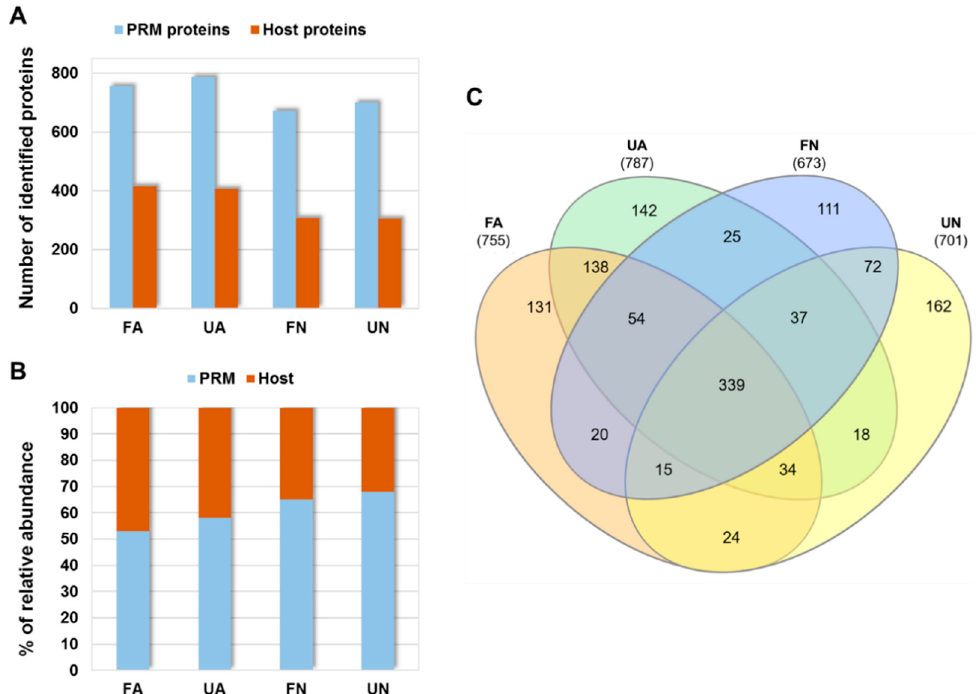
Figure 1. Proteomics results in PRM. ( A ) Proteins were identified with FDR < 0.01 and at least two PSMs per protein in at least one of the analyzed samples. ( B ) Percentage of relative abundance for PRM and host proteins calculated with respect to the total number of PSMs detected in each sample group. ( C ) Venn diagram showing PRM protein distribution between different groups analyzed. FA: engorged female adult mites, UA: non-fed female adult mites, FN: engorged proto- and deutonymphs, UN: unfed proto- and deutonymphs.